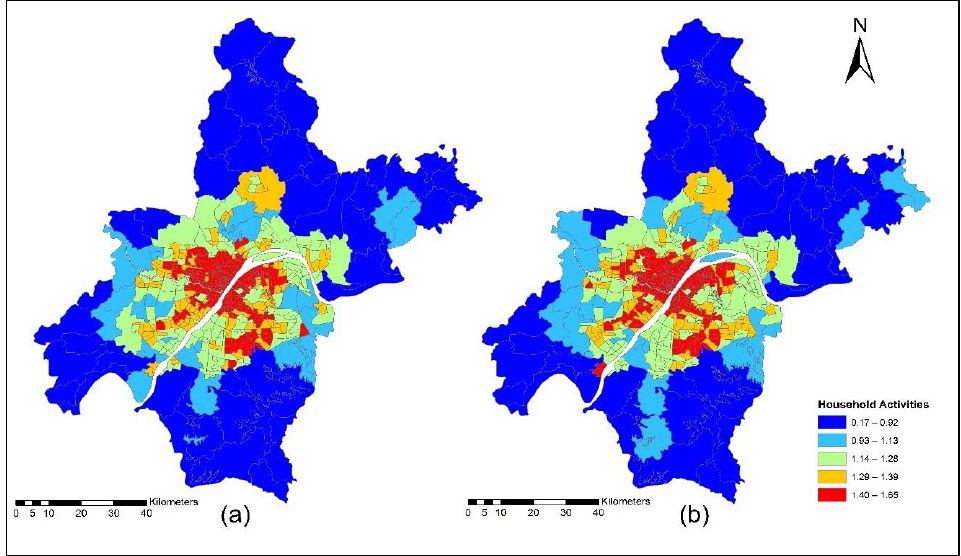
Figure 8. ( a , b ) Accessibility of household activities: ( a ) during morning peak for the year 2012; ( b ) during morning peak for the year 2015.